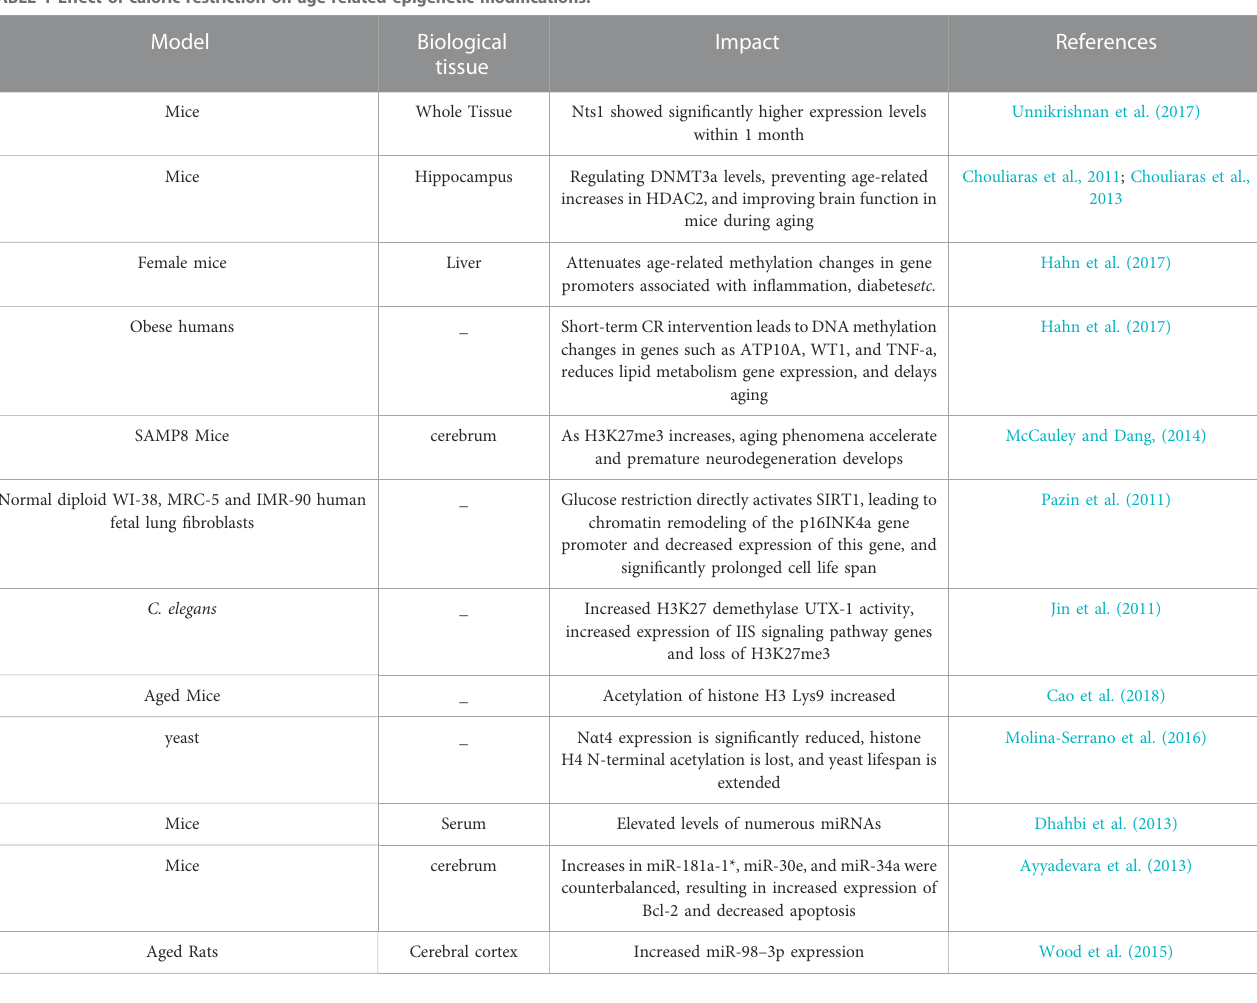
TABLE 1 Effect of caloric restriction on age-related epigenetic modi fi